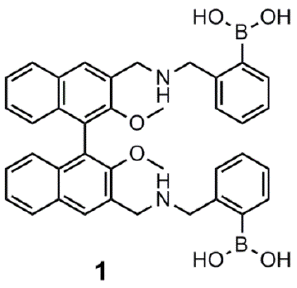
Figure 1. The chiral binol sensor, 1 , developed by James and co-workers